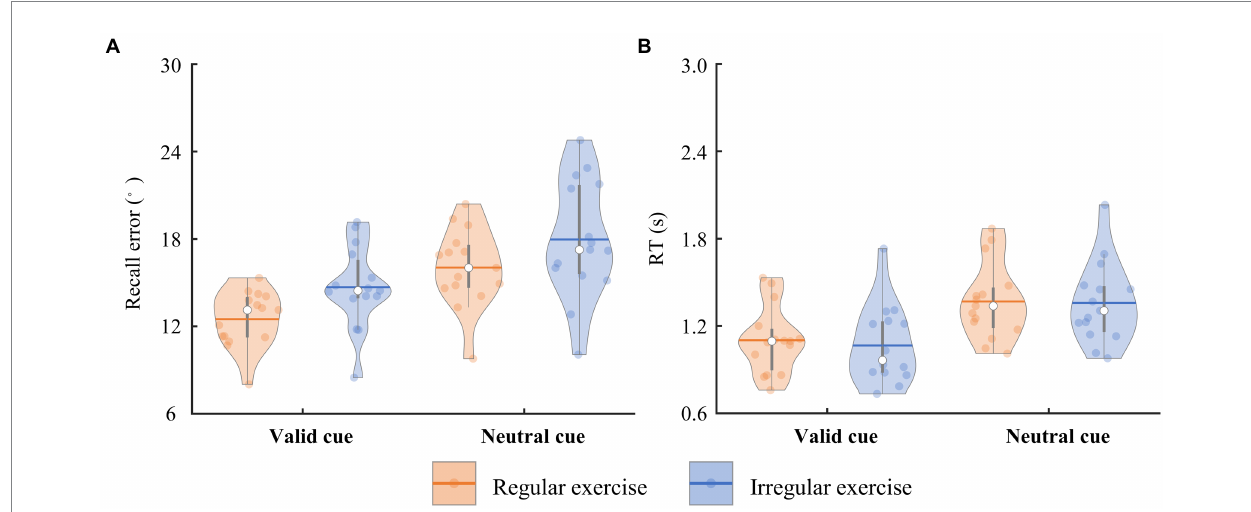
FIGURE 2 The trial-averaged recall error and RT of the two groups. (A) The recall error of the regular and irregular exercise groups in the neutral and valid cue conditions. The horizontal bars indicate the averaged values across participants. Each dot marks a participant. Same below. (B) The RT of the regular and irregular exercise groups in the neutral and valid cue conditions.